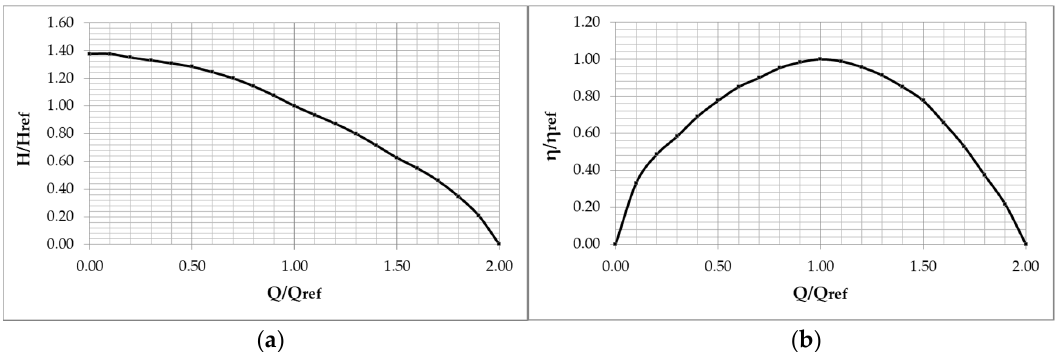
Figure 5. ( a ) Dimensionless head of pump and ( b ) pump efficiency as a function of the dimensionless water flow [20].